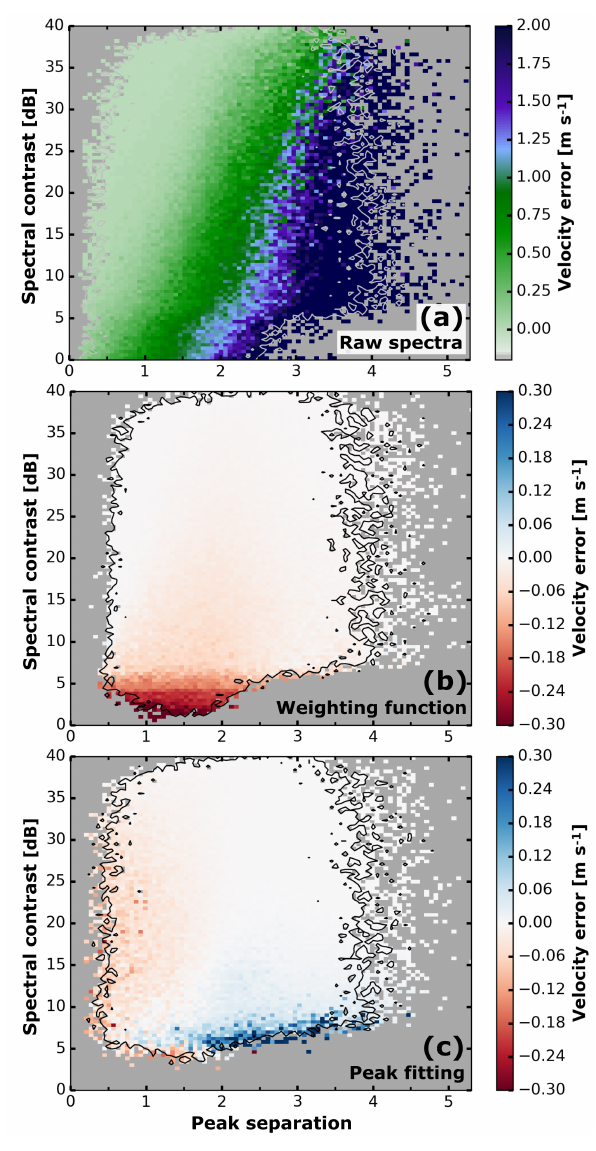
Figure 13. Velocity error before the separation (a) , with the weight- ing function (b) and peak fitting (c) . Shown is the bin mean for all Monte Carlo spectra within the respective bins. The black outline marks bins containing more than seven values. Bins without any simulations are marked in